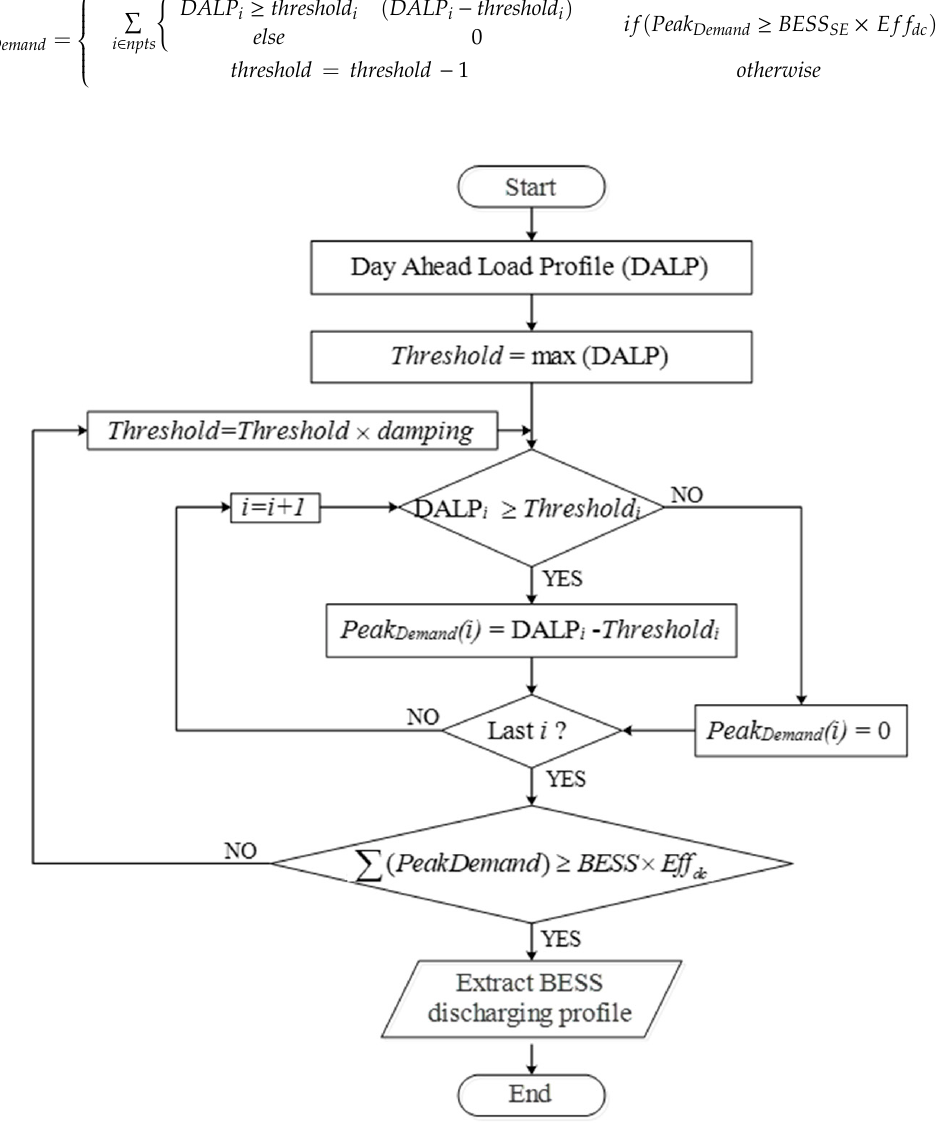
Figure 8. Peak reduction strategy algorithm (discharging algorithm).